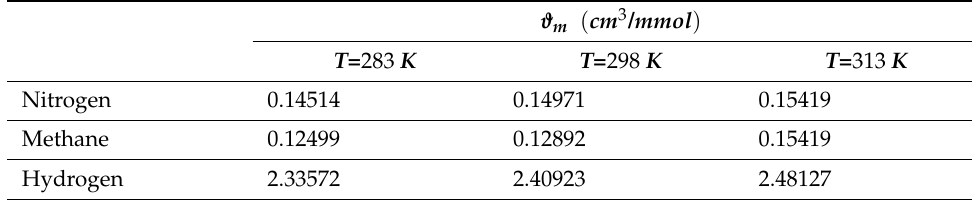
Table 6. Molar volume of the adsorbed